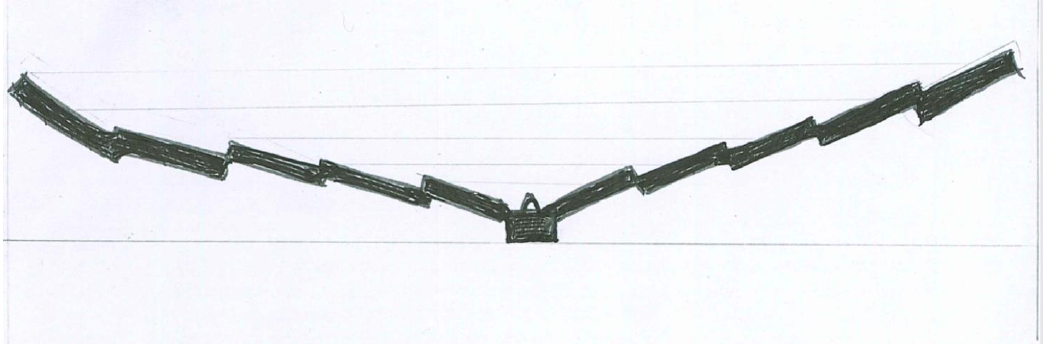
Figure 8. The cross-section plan of the Quanzhou Bay shipwreck. Courtesy of Mr. Eason Y.